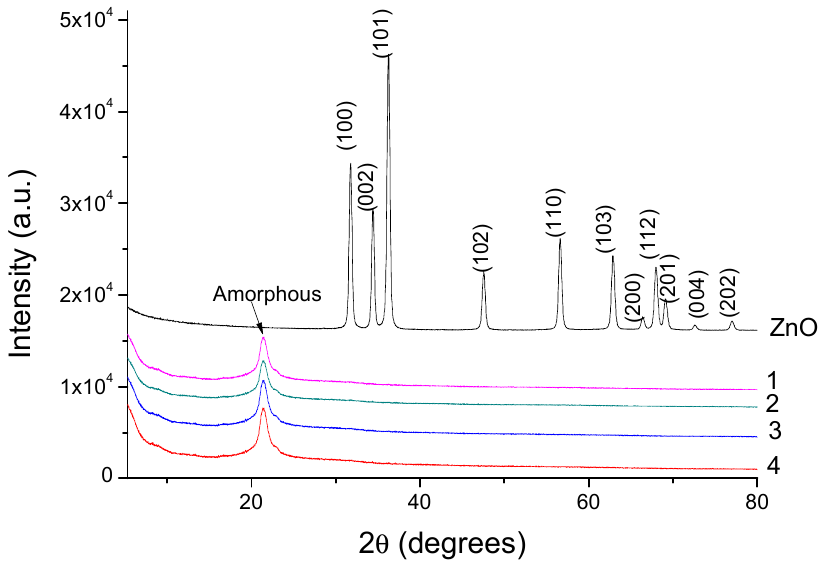
Figure 7. XRD patterns of unfunctionalized ZnO (M) and of dried ZnO materials modified with (1) GPTMS, (2) PhTES, (3) OTES, and (4) ODTES, respectively.